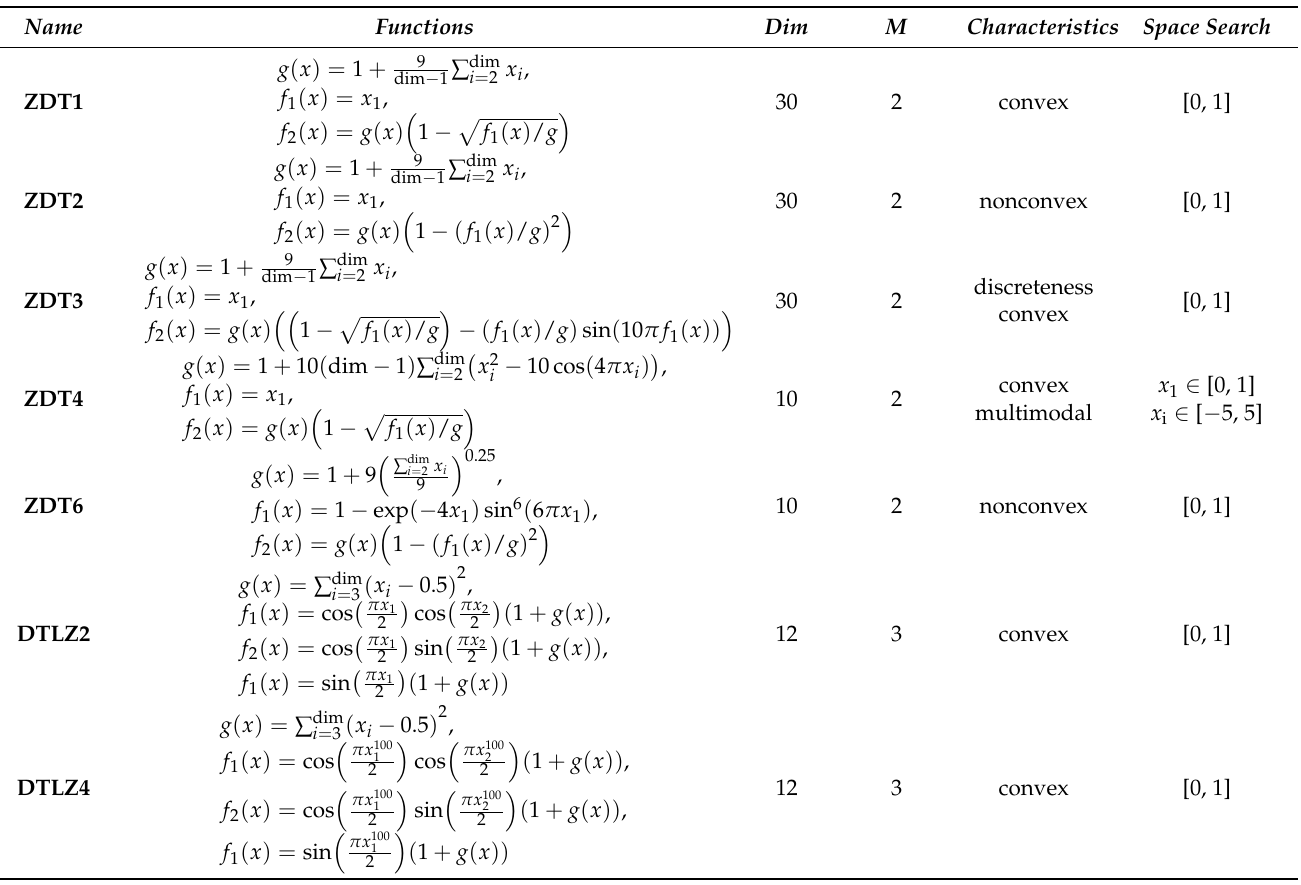
Table 1. Seven classic multi-objective benchmark